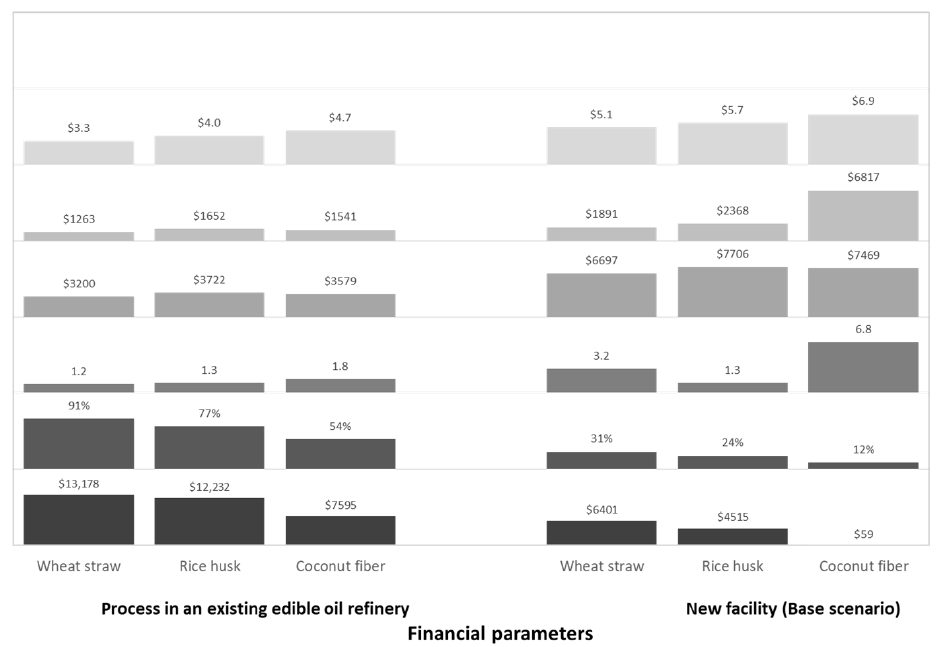
Figure 3. Financial parameters for the three supports (wheat straw, rice husk and coconut fiber) for a process in an existing edible oil plant and in a new facility (base scenario).